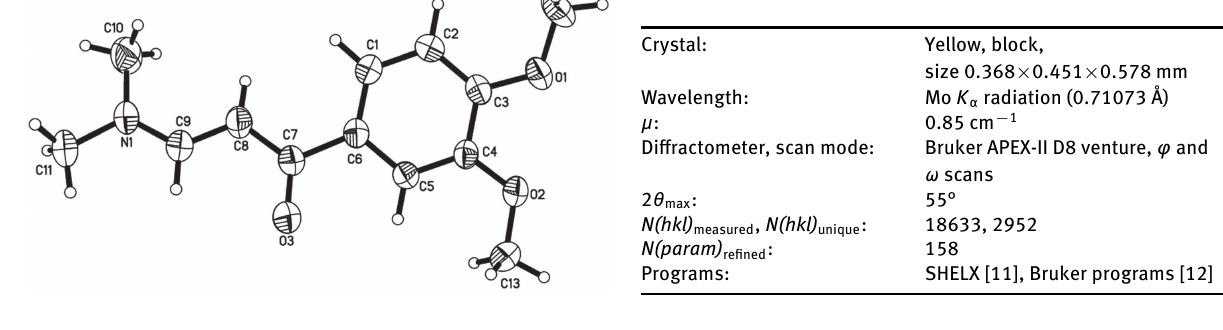
Table 2: Fractional atomic coordinates and isotropic or